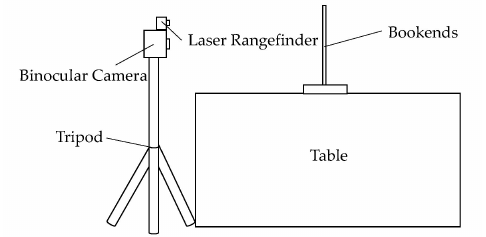
Figure 16. The accuracy of measured distance based on the proposed